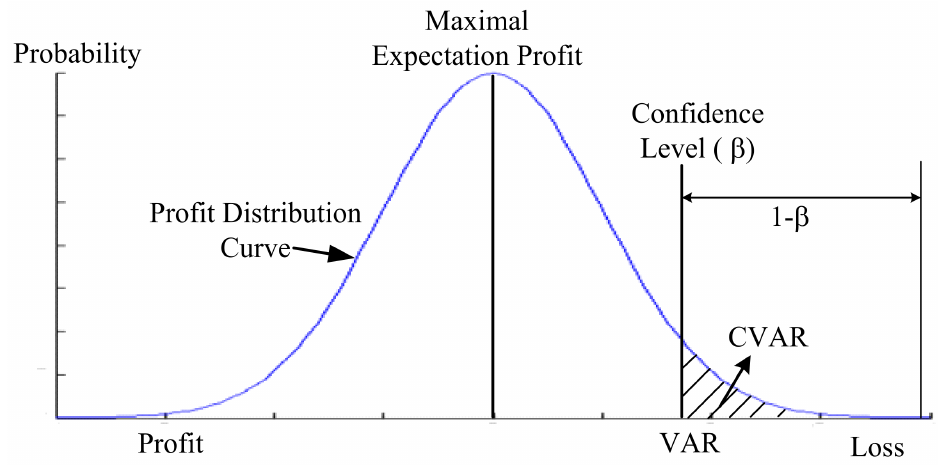
Figure 2. Diagram of the VAR and CVAR